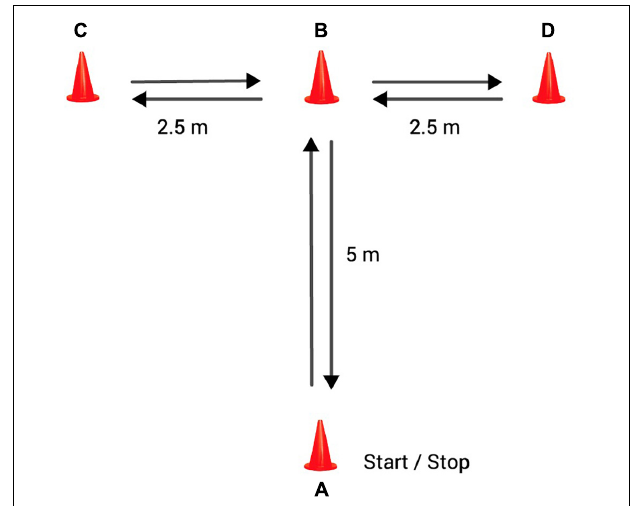
FIGURE 1 | Change of direction ability